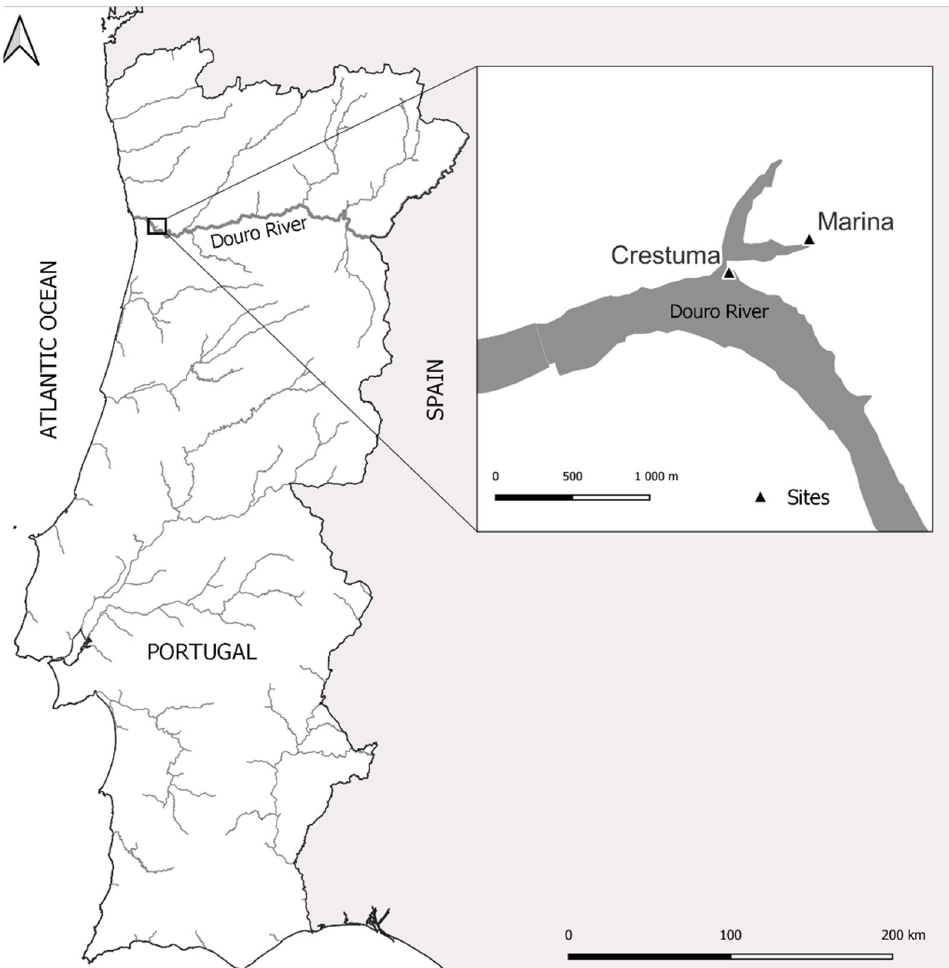
Figure 1. Map location of the study area with the sampling sites positions in the Douro River: the Crestuma ‐ Lever reservoir: Crestuma (41°04 ′ 38.2 ″ N, 8°28 ′ 20 ″ W) and Marina (41°04 ′ 45 ″ N, 8°27 ′ 58 ″ Crestuma-Lever reservoir: Crestuma (41 ◦ 04 (cid:48) 38.2” N, 8 ◦ 28 (cid:48) 20” W) and Marina (41 ◦ 04 (cid:48) 45” N, 8 ◦ 27 (cid:48) 58” W).